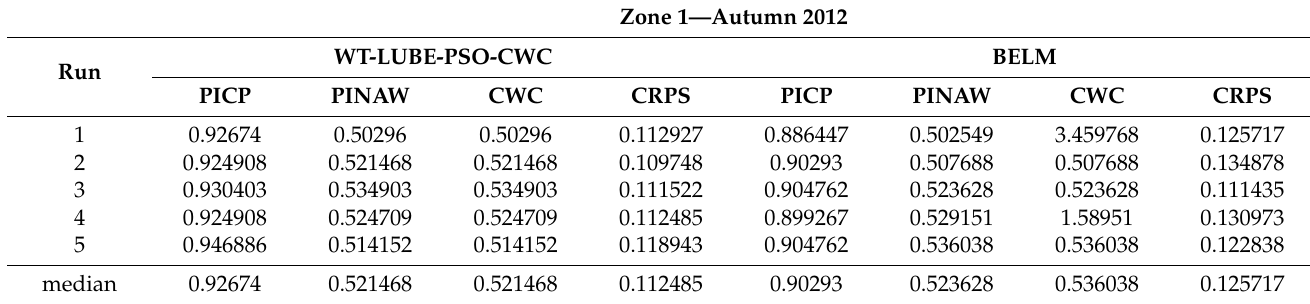
Table 4. Results of the evaluation of 5 training sessions of WT-LUBE-PSO-CWC and BELM models in zone 1 for autumn 2012 at the 0.9 confidence level.